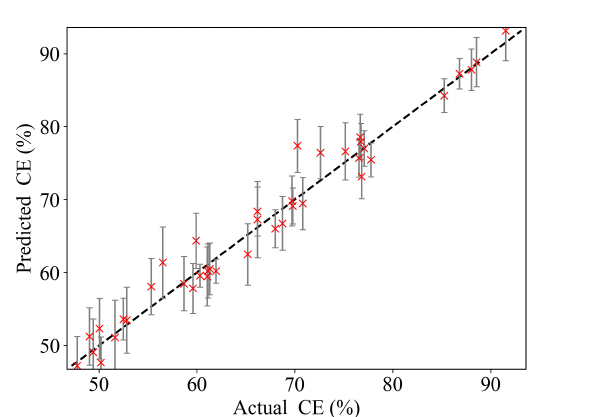
Figure 6. Diagonal plot of the GP predictions for the CE of the SCWFB reactor with the error bars indicating 95% confidence interval of the